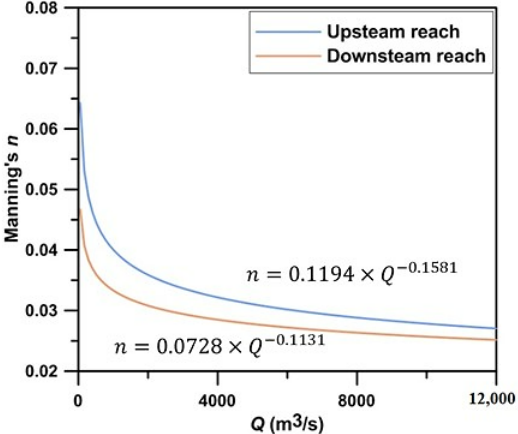
Figure 6. Identified power functions for upstream reach and downstream